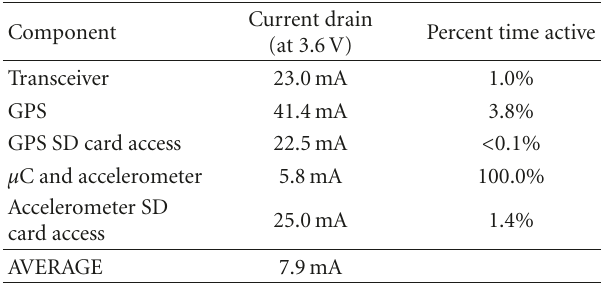
Table 3: Measured power consumption and percent time active per component for the deployed system.